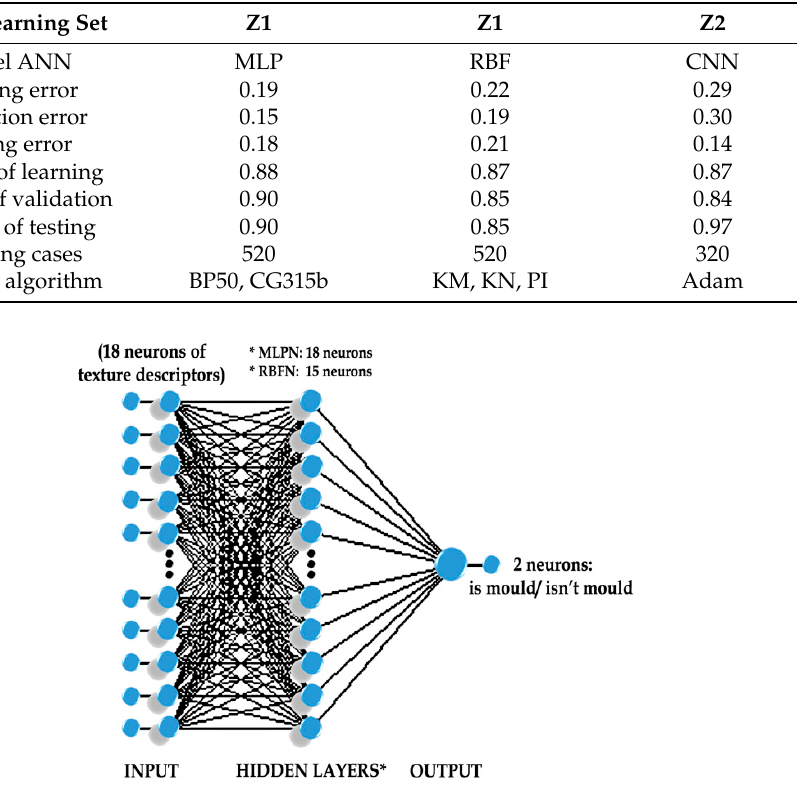
Figure 5. Structure of selected MLP neural networks with 18 neurons in the hidden layer (MLPN) and RFB neural networks with 15 neurons in the hidden layer (RBFN).